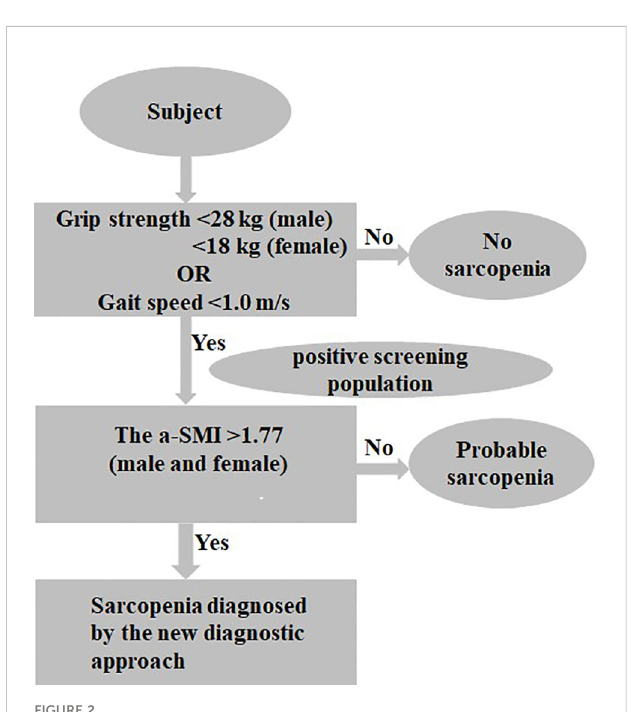
FIGURE 2 The new diagnostic approach for sarcopenia.